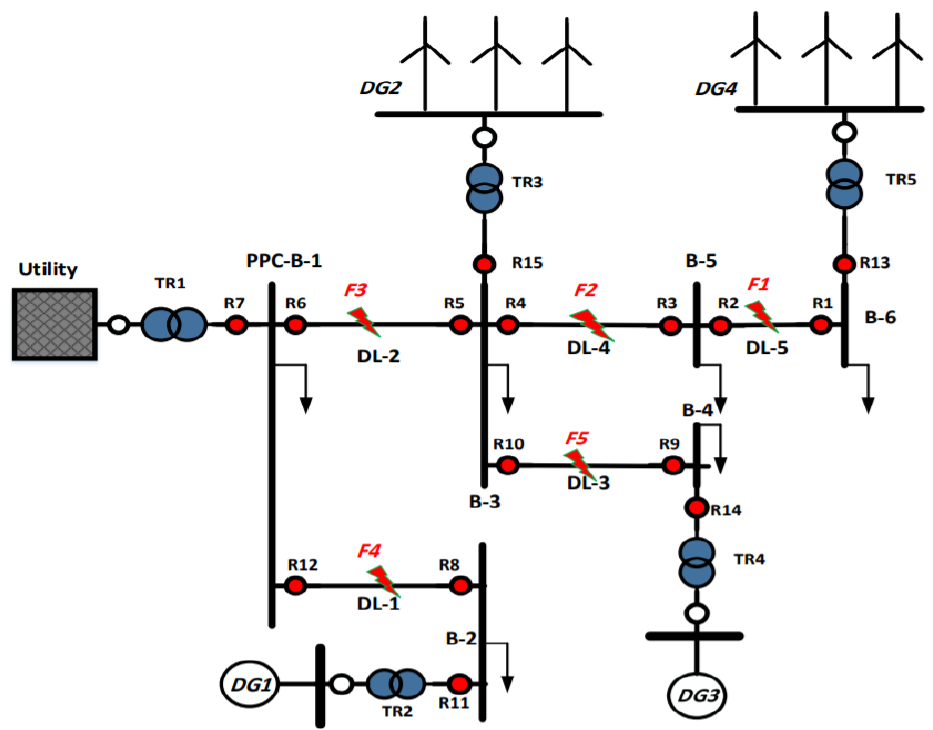
Figure 10. IEC MG Benchmark (Large-Scale Network). Table 6. The Overall OT for the radial IEC MG—Mode 1.